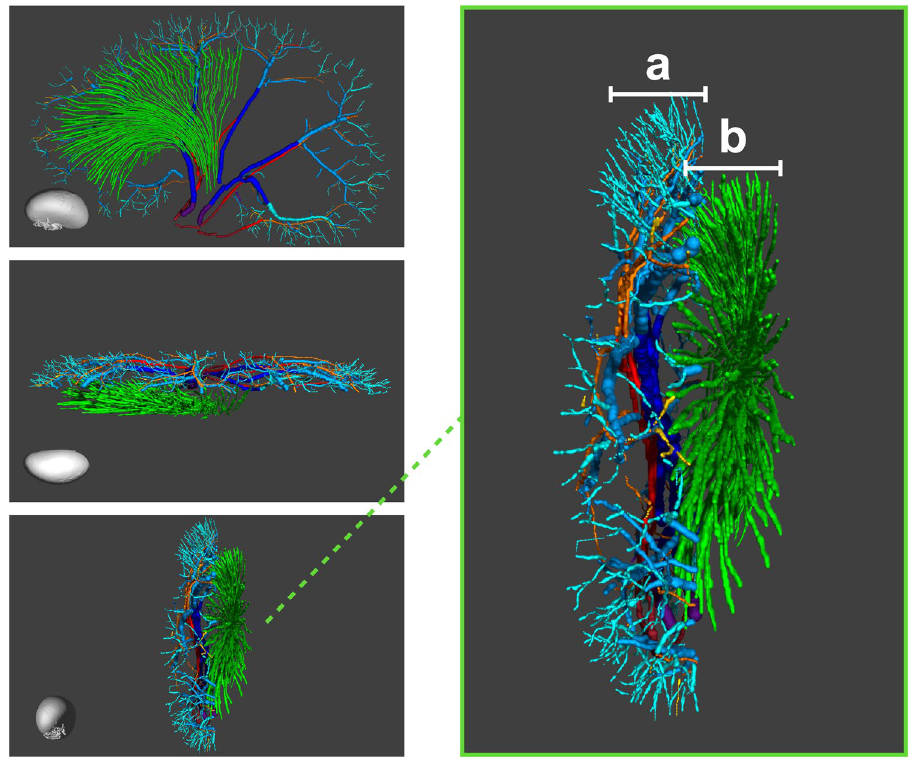
Figure 7. 3D illustration with rotation of the manually drawn vessel centerlines in the μ CT. The 3D illustration shows the vasa recta bundles (green, descending and ascending vasa recta are not distinguishable), and larger arteries and veins (purple = renal vein branches, dark blue = segmental veins, blue = arcuate veins, turquoise = cortical radial veins, dark red = renal artery branches, red = segmental arteries, orange = arcuate arteries, yellow = cortical radial arteries). Insert: ( a ) shows the μ CT vessel centerlines in super-resolution ultrasound scan 2 overlap. ( b ) shows approximately half of the well-resolved vasa recta segmented in the μ CT in the super-resolution ultrasound scan 1